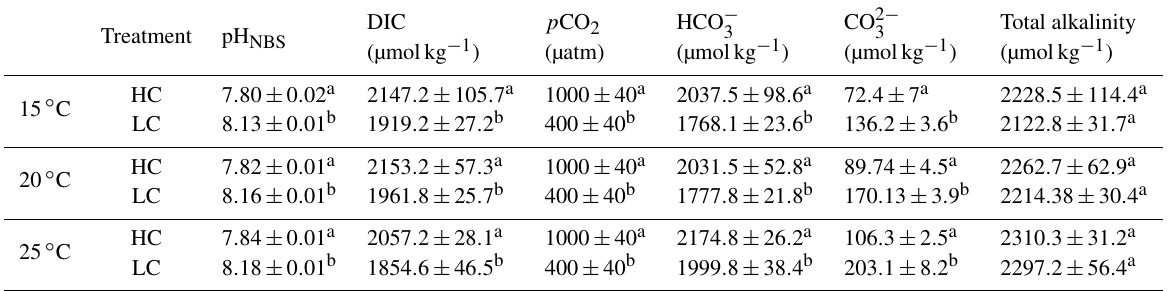
Table 1. Mean values of the seawater carbonate system parameters under HC (1000µatm) and LC (400µatm) at 15, 20 and 24 ◦ C. The cell concentrations of all cultures were maintained below 5 × 10 4 cellsmL − 1 and pH variations were < 0 . 04 units.